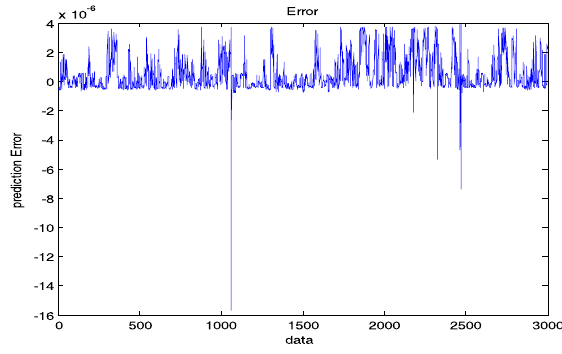
Fig. 3 Prediction Error